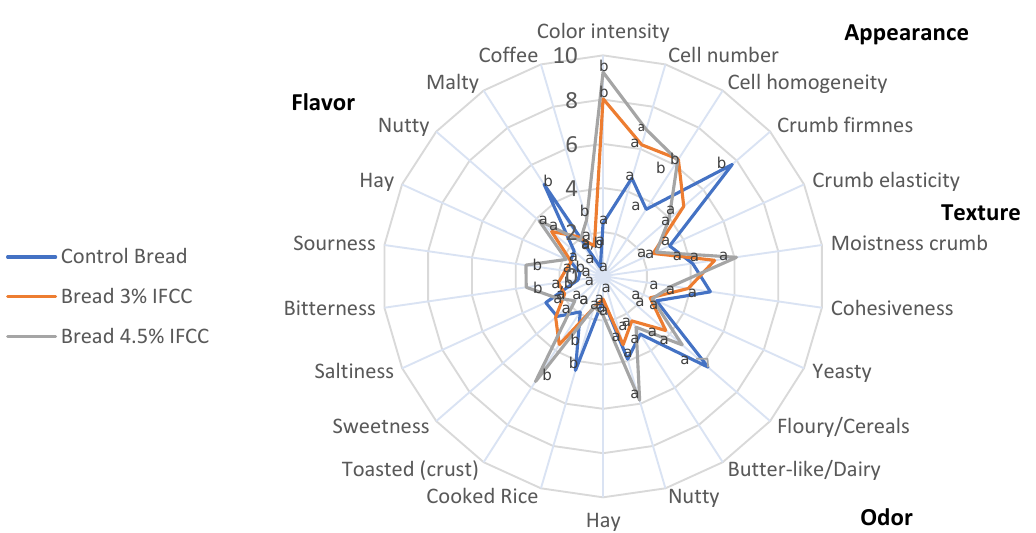
Figure 3. Results of the lineal scale (0–10) test of gluten-free breads by 8 trained panelists. Different letters indicate significant differences among samples (Tukey Test, p < 0.05).